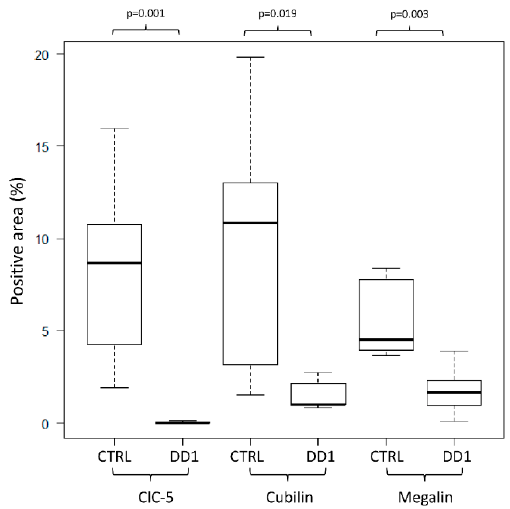
Figure 4. ClC-5, cubilin, and megalin quantitative analysis. Morphometric analysis showed a significant decrease in the percentage of positive area in kidneys of DD1 patients than in control kidneys for all molecules examined. Data were analyzed using the Mann–Whitney U-test. CTRL = control.